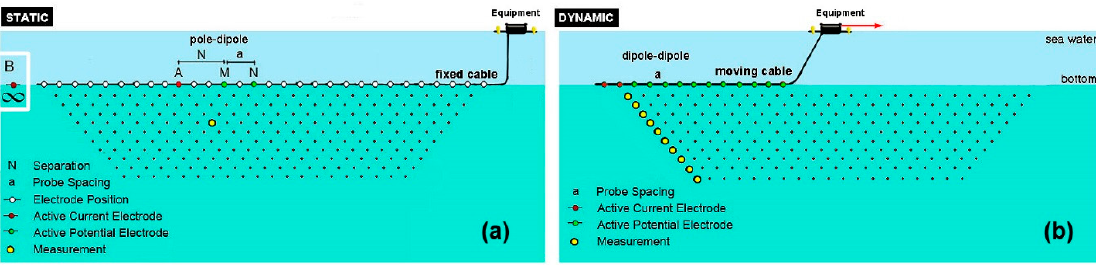
Figure 4. ( a ) Static and ( b ) Dynamic submerged survey modes employed in Olous for the electrical resistivity tomography (ERT) data collection along individual 2-D lines.